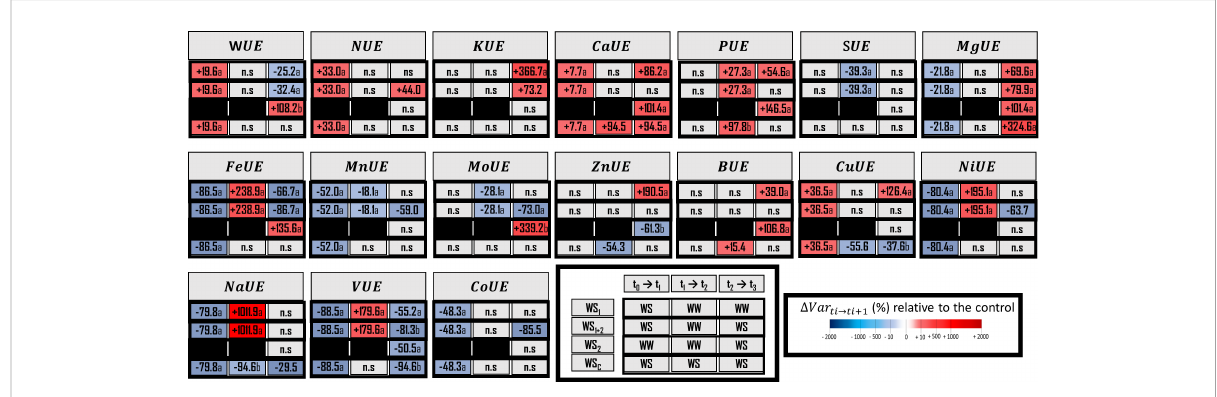
FIGURE 4 Water use ef fi ciency (WUE) and element use ef fi ciency (EUE) for macronutrients, micronutrients and three bene fi cial elements. Elements (E) characterized are N, Nitrogen; K, Potassium; Ca, Calcium; P, phosphorus; S, sulfur; Mg, magnesium; Fe, iron; Mn, manganese; Mo, molybdenum; Zn, zinc; B, boron; Cu, copper; Ni, nickel; Na, sodium; V, vanadium, and Co, cobalt. The effect of each treatment (WS 1 , transient vegetative stress; WS 1+2 , recurrent stress; WS 2 , transient reproductive stress; WS c , continuous stress) was expressed relatively to control plants (WW c ) at each harvest (t 1 , t 2 , t 3 ; n = 4 or n = 5) ( D Var t i ! t i+1 ). Boxes were colored in red when the treatment induced an increase of the variable, and in blue when the treatment induced a decrease of the variable compared with conrol plants (WW c ); the intensity of the effect was characterized by the scale of color and the value (percent compared with WW c ) present in the box. Primary data are available in Supplementary Table S4. Letters regroup treatment with non-signi fi cant difference for each harvest.